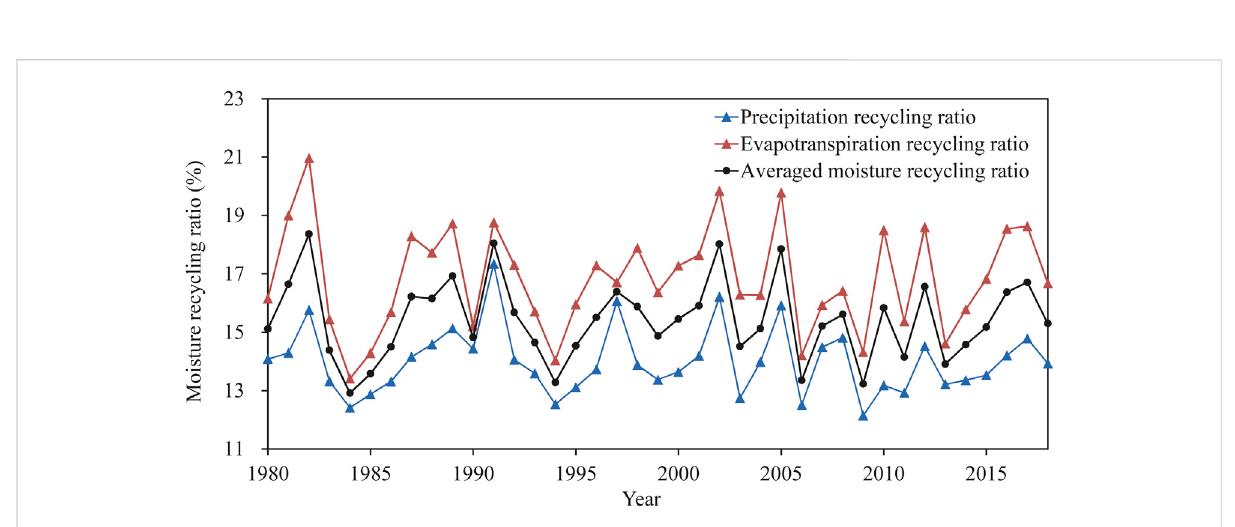
FIGURE 4 Annual moisture recycling ratio of the Tarim